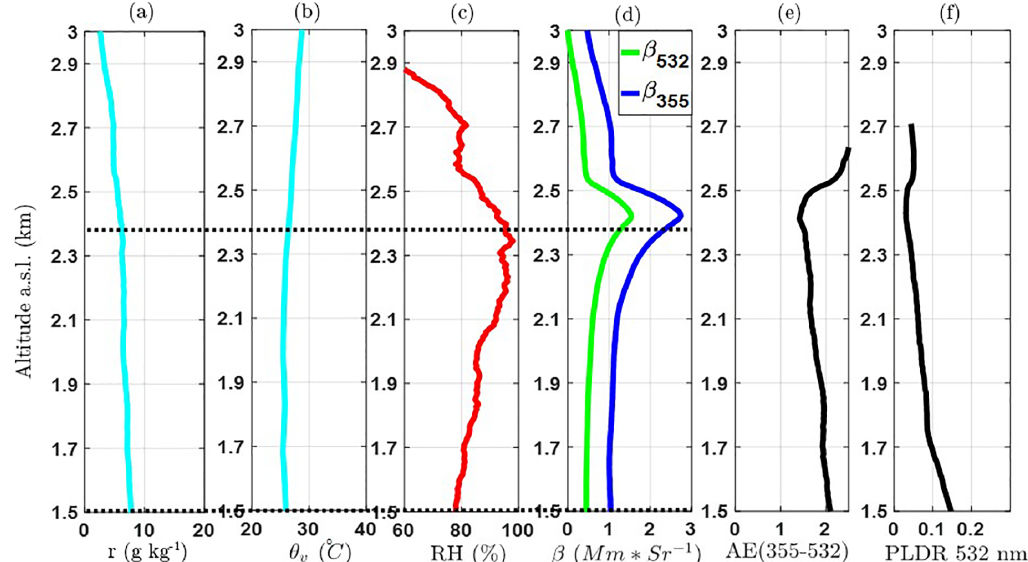
Figure 5. (a) Water vapor mixing ratio; (b) virtual potential temperature; (c) relative humidity obtained from synergy RL + MWR; (d) particle backscatter coefficient at 355 and 532nm; (e) backscatter-related Ångström exponent (355–532nm); and (f) particle linear depolarization ratio. All profiles correspond to a 30min average from 20:30 to 21:00UTC on 16 June 2016 at the EARLINET IISTA-CEAMA